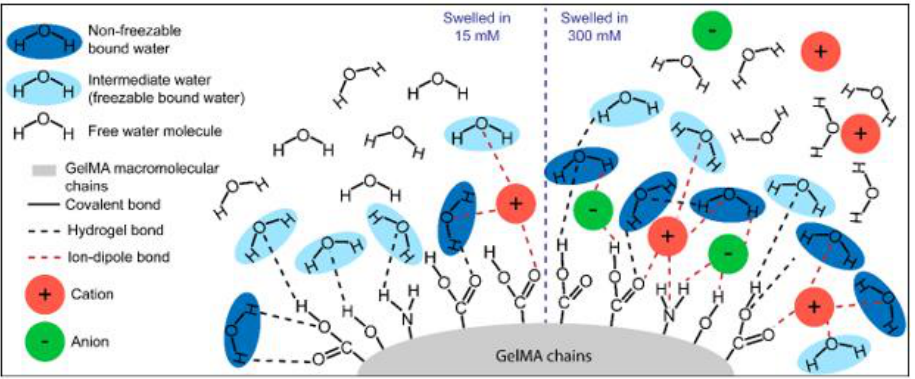
Figure 6. Graphic illustration of the proposed mechanism of water–GelMA interactions in GelMA hydrogels swelled at different ionic strengths. W f , W nfb and free water molecules are presented with the same conventions as in Figure 3. On the right, the highest ionic strength of the swelling media reinforces the W nfb fraction, more than for the lowest ion concentration on the left, due to increased number of ion–dipole bonds.